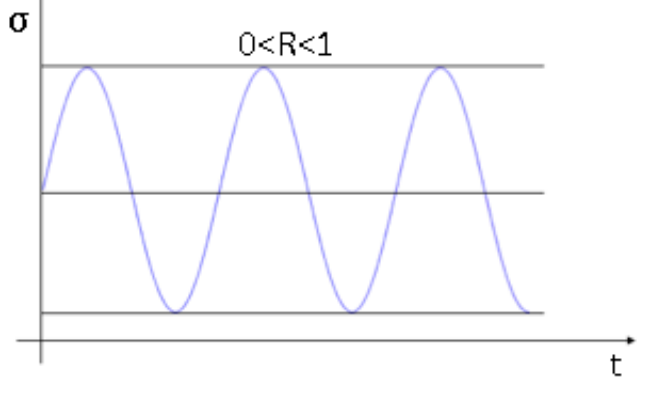
Figure 10. Stress cycle diagram under fluctuation cycle.